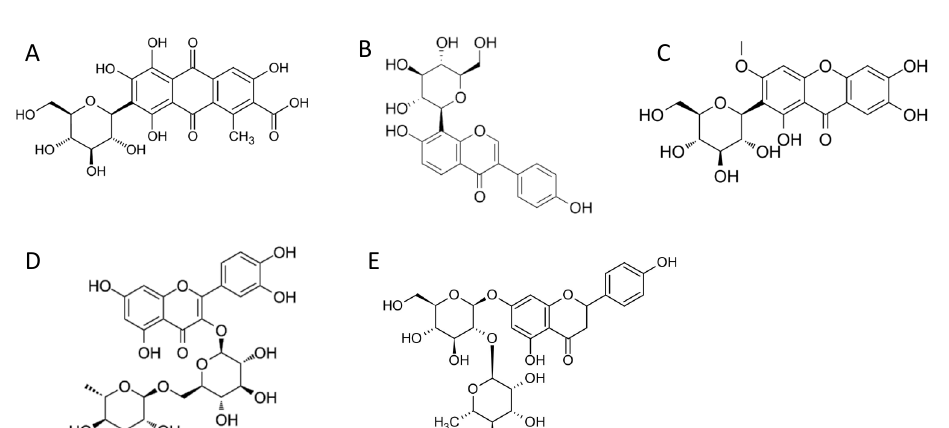
Figure 3. Structure of C- and O-glycosides used as substrates by Sc POx. ( A ) carminic acid; ( B ) puerarin; ( C ) mangiferin; ( D ) rutin and ( E ), naringin. Table 1. Activities of Sc POx for different monosaccharides at final concentrations of 200 mM and various C- and O-glycosides at final concentrations of 0.2 mM, measured with DCIP as electron acceptor at 30 °C in 50 mM potassium phosphate buffer, pH = 6.5 in triplicates.